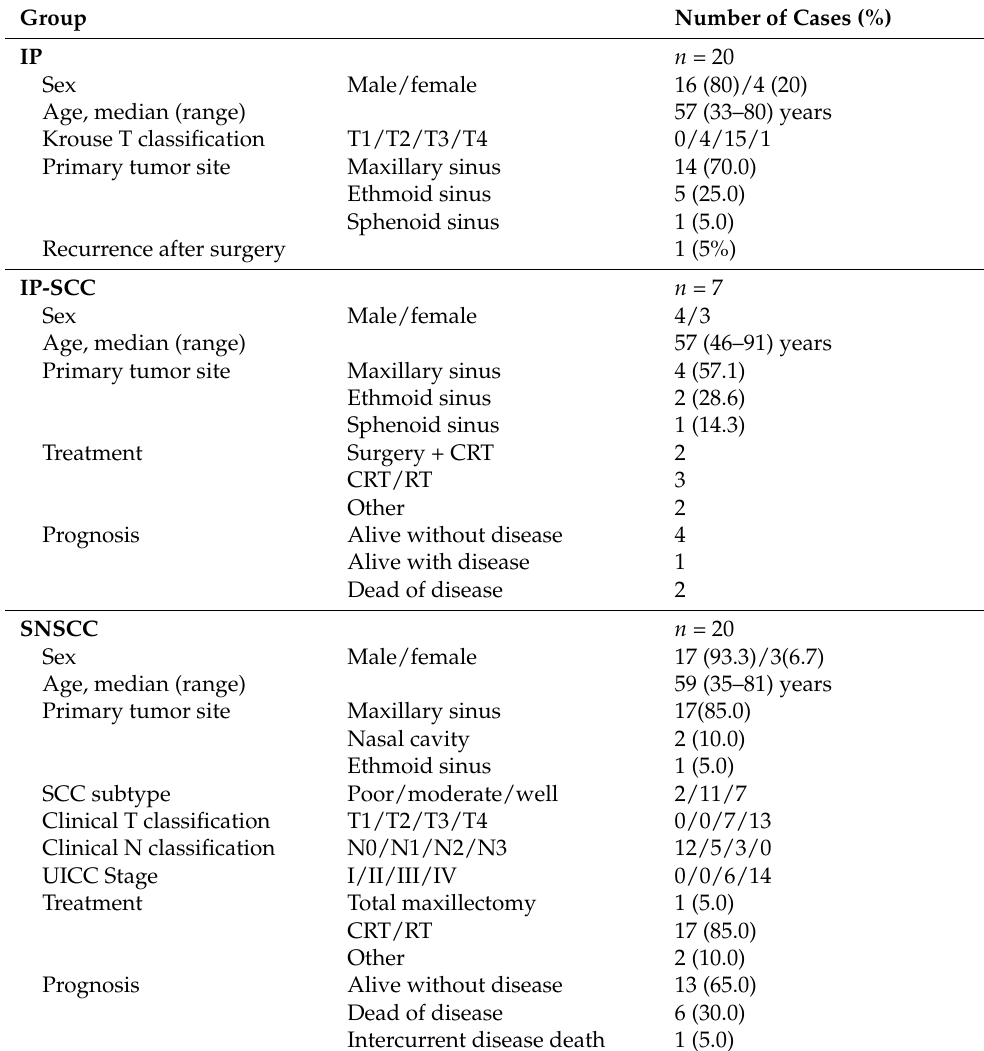
Table 1. Patient